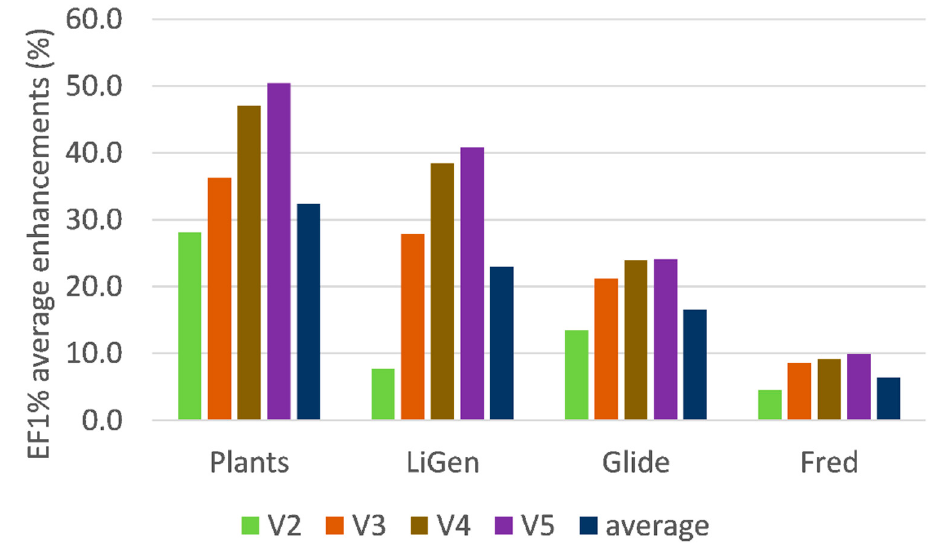
Figure 2. Average EF1% enhancements (in percentage values) due to the generation of the consensus models when including two (V2), three (V3), four (V4), or five (V5) variables plus overall averages. The reported values are computed by averaging the EF1% enhancements for both inhibition thresholds.